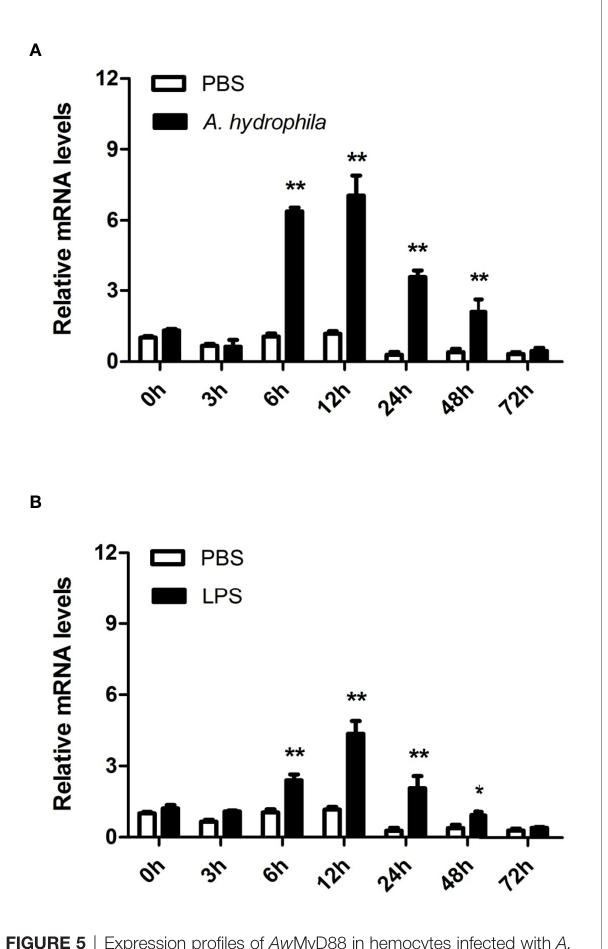
FIGURE 5 | Expression pro fi les of Aw MyD88 in hemocytes infected with A. hydrophila (A) or LPS (B) in vivo . The b -actin gene was used as an internal reference gene to normalize the expression level. The expression level of the control group (PBS) at 0 h postchallenge was set as 1.0, and the results are presented as mean ± S.E. ( N = 3). Signi fi cant differences between the immune challenge and control groups are indicated by the asterisks (* and ** represent P < 0.05 and P < 0.01, respectively).